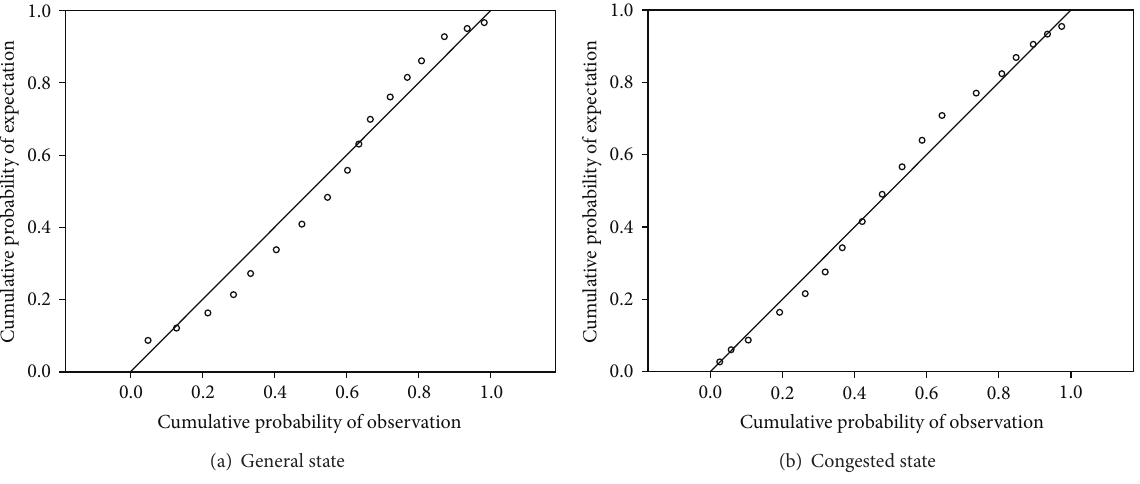
Figure 13: P-P figure of normal distribution fitting.